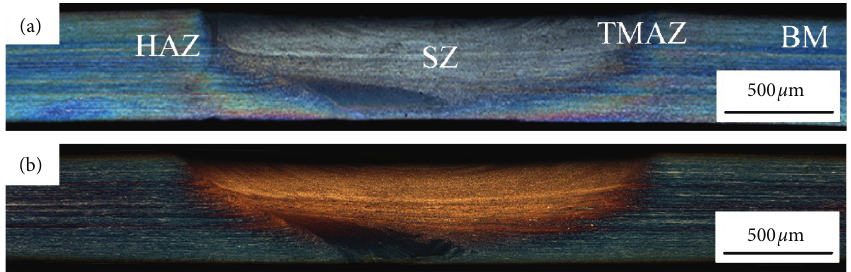
Figure 2: Cross sections of joints obtained at different welding speeds: (a) 30mm/min and (b) 50mm/min.